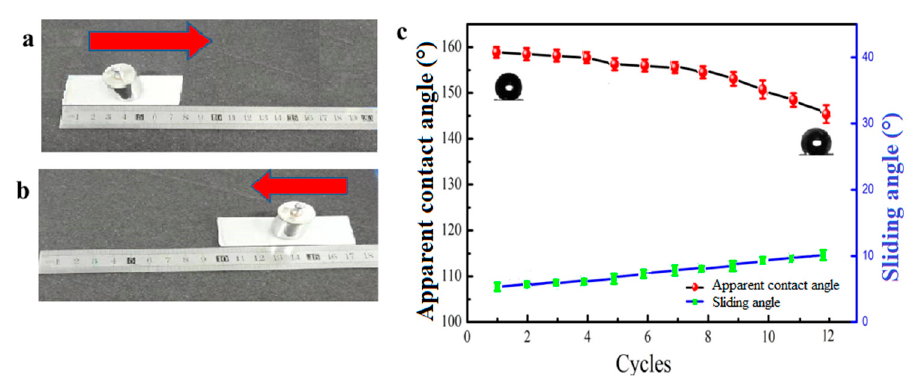
Figure 7. ( a , b ) One abrasion test cycle and( c ) the change of apparent contact angle and sliding angle after cycles of abrasion.